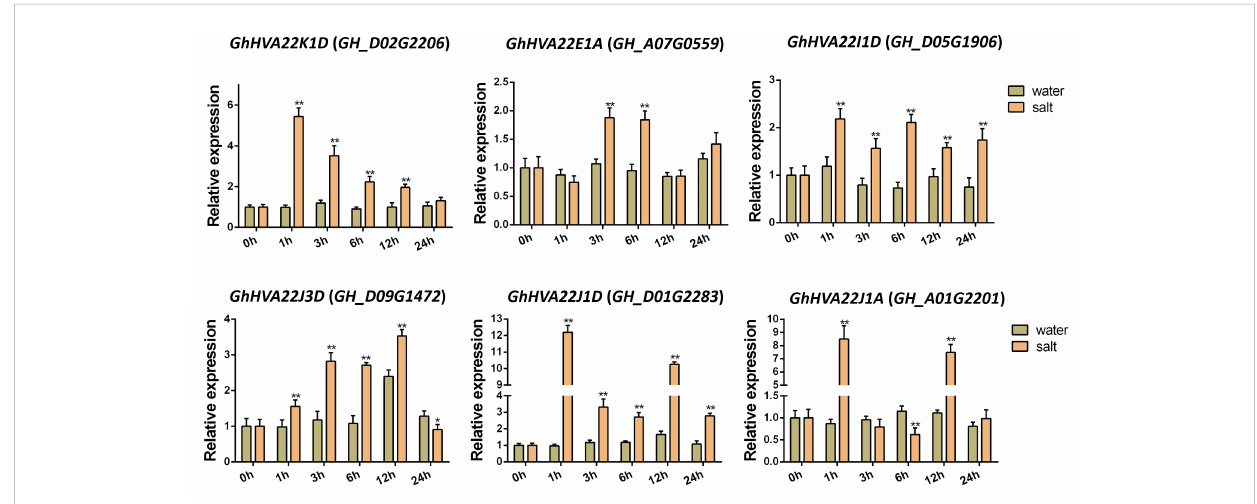
FIGURE 6 Expression patterns of six GhHVA22 genes in response to salt treatment. Each sample was sampled at 0, 3, 6, 12 and 24h after treatment. The results are the meanof three replicates. Signi fi cant differences are indicated by * (P < 0.05) and ** (P < 0.01, Student